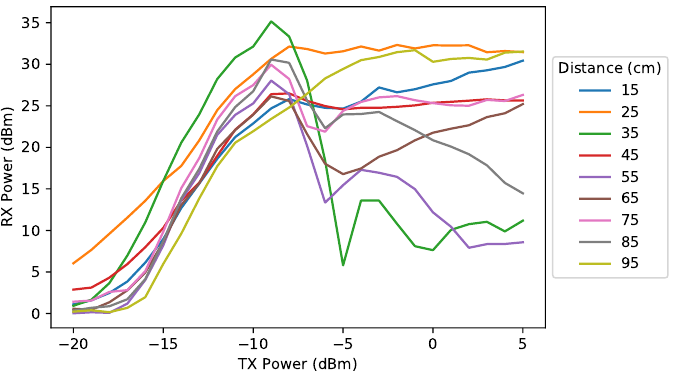
Figure 12. Difference between transmitted and received signal strength for the laptop over three distances.